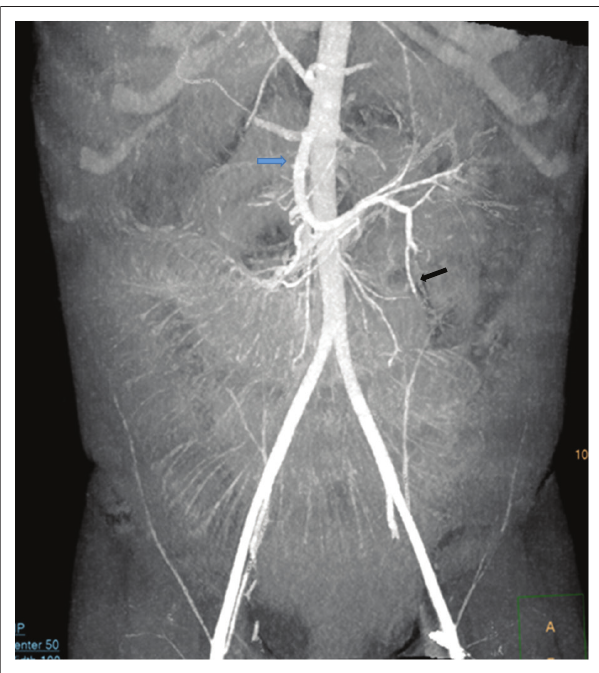
FIGURE 3: Coronal reconstructed maximum intensity projection image demonstrating the superior mesenteric artery (blue arrow) and its branches including the ileocolic (black arrow) from which the appendicular artery arises. The vessels are seen coursing to the left, corresponding to the position of the caecum and appendicolith. This is in contrast to the normal course towards the right lower